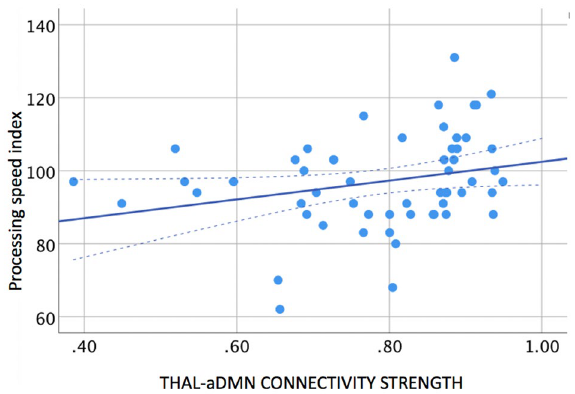
Figure 3. Relationship between functional connectivity strength in the thalamic and aDM resting state networks (x-axis) and processing speed index (y-axis) at 7